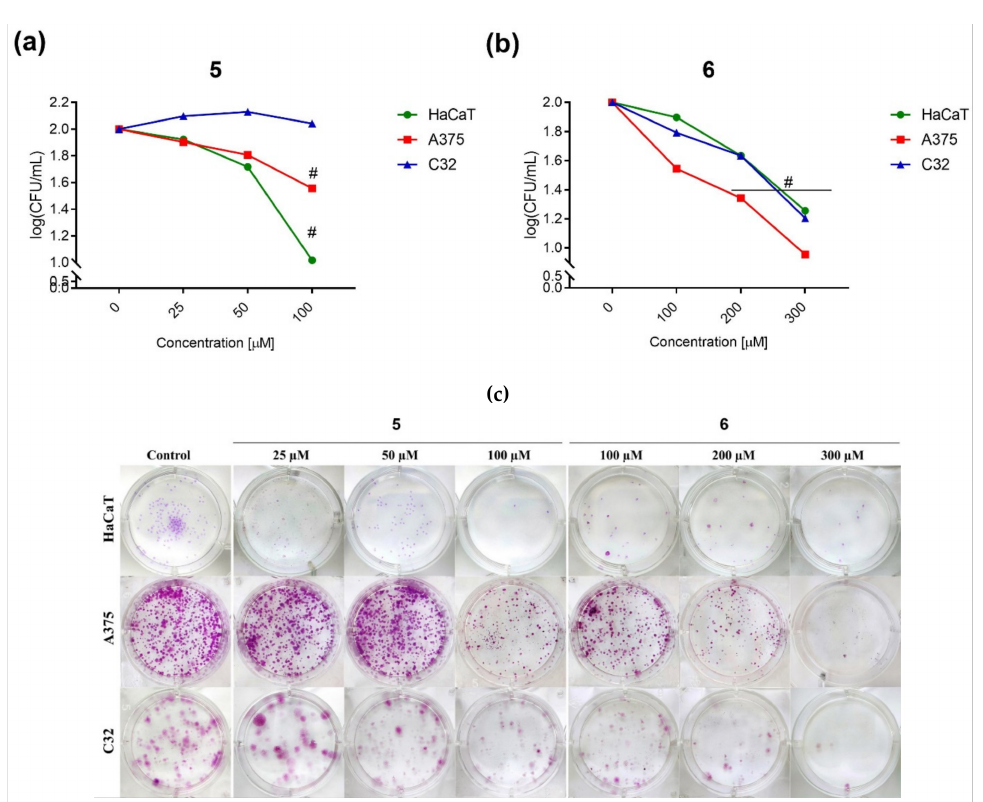
Figure 4. Colony-forming properties of the C32, A375 and HaCaT cells after incubation with ( a ) compound 5 and ( b ) compound 6 (CFU—colony forming units expressed per mL); ( c ) clono- genic assay visualization for 5 and 6 compounds. # p ≤ 0.05.